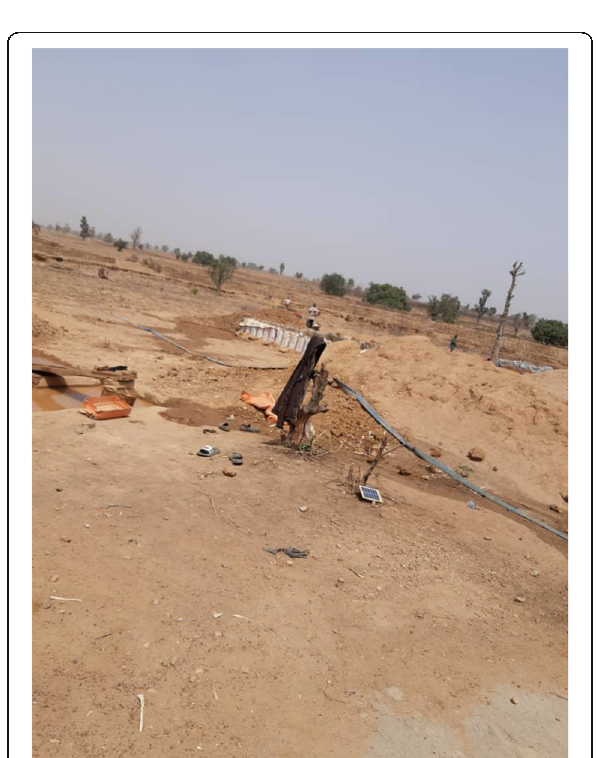
Fig. 3 Site 2 of the local mining area